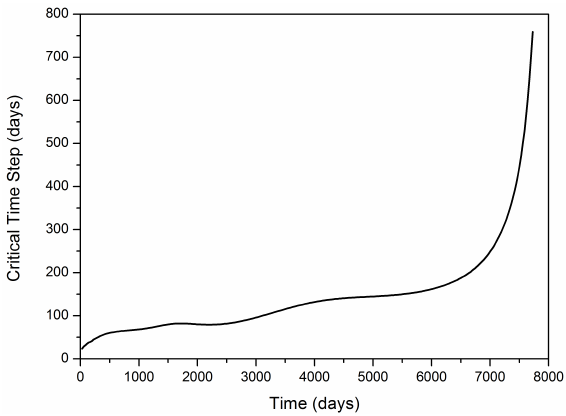
Figure 10. Critical time-step curve as a function of time for the non-iterative secondary recovery.